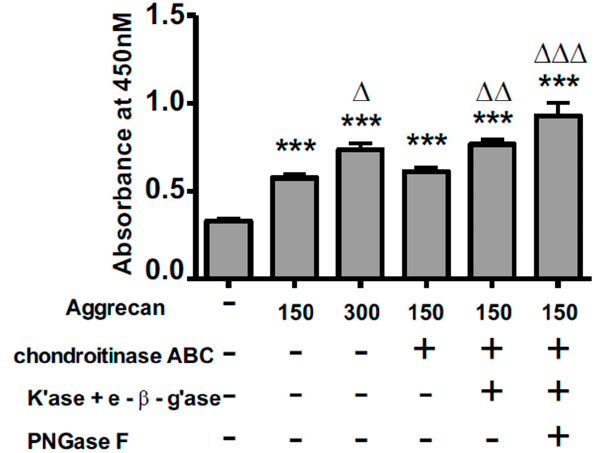
Figure 3. ELISA assay demonstrating aggrecan adsorption to wells. No aggrecan or aggrecan at 150 or 300 µ g / mL was plated into wells of a 96-well plate and were subjected to the enzyme digestion protocol. Wells were reacted with primary antibody against the G1-domain, reacted with a horseradish peroxidase secondary antibody, incubated with peroxidase substrate, and the absorbance was read at 450 nm. ANOVA analysis was conducted followed by a Bonferroni post-hoc analysis. Asterisks (*) represent di ff erences in absorbance from the no aggrecan condition while ∆ represents di ff erences from 150 µ g / mL intact aggrecan. *** p < 0.001, ∆ p < 0.05, ∆∆ p < 0.01, ∆∆∆ p <